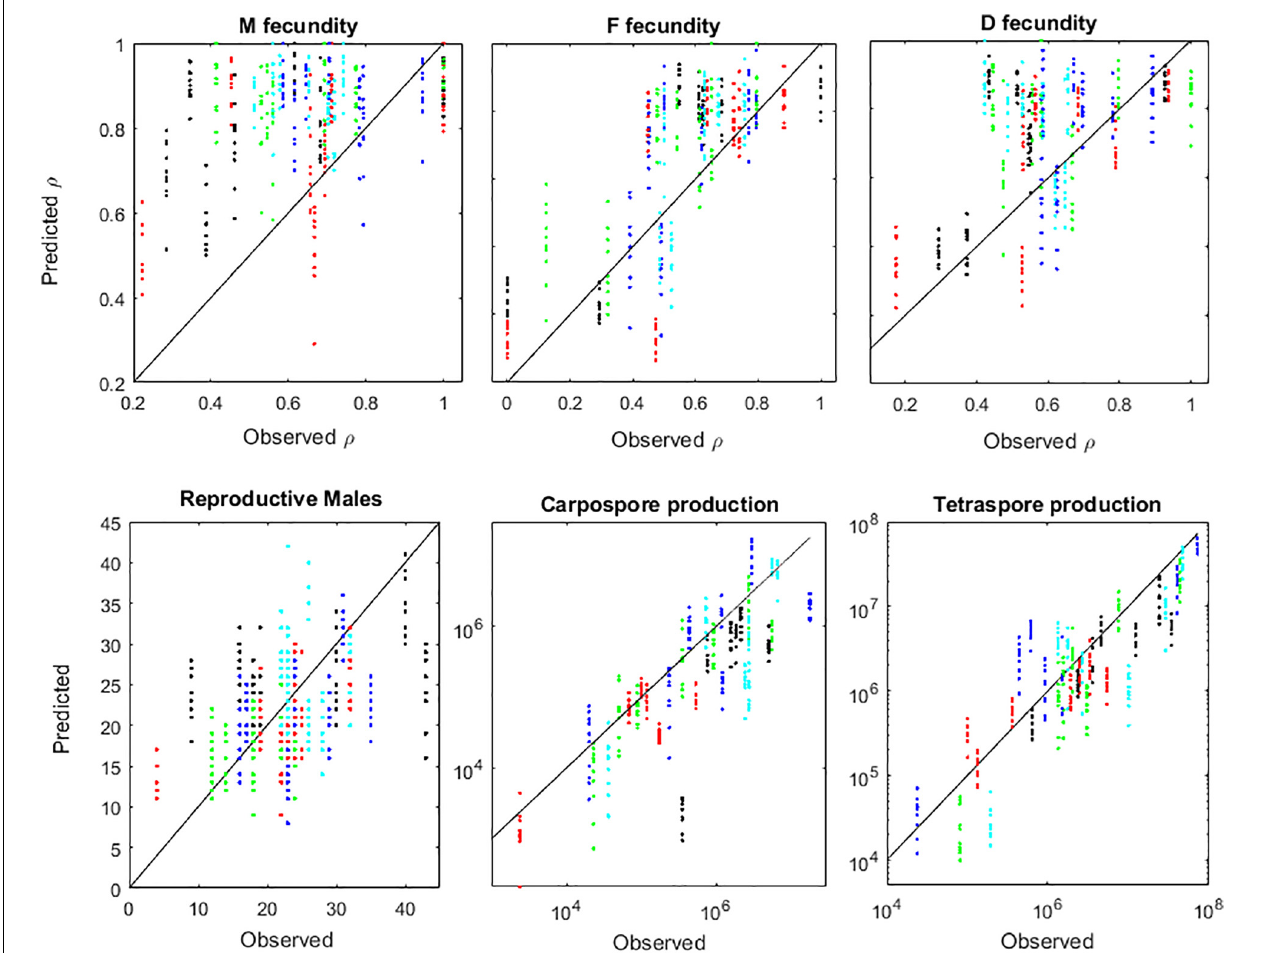
FIGURE 9 | Validation of the IBM run in full mode. Upper panels: comparison between observed and predicted probabilities ( ρ ) of males (M), females (F), and diploids (D) becoming fecund. Bottom panels: observed and predicted numbers of reproductive males, and the total production of carpospores and tetraspores. Markers represent plots Corral 1 (black), Corral 2 (red), Niebla 1 (green), Niebla 2 (light blue), and Niebla 3 (dark